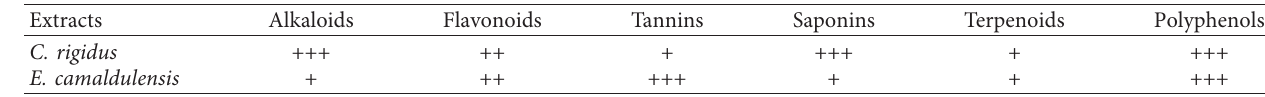
Table 2: Phytochemical components of the methanol extracts of C. rigidus and E. camaldulensis .